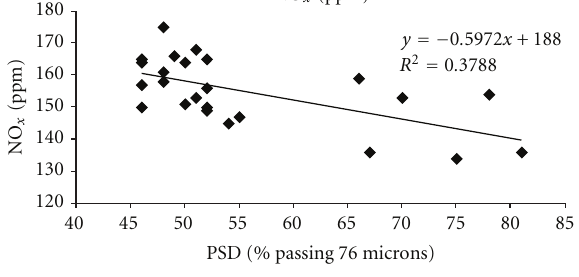
Figure 4: PSD versus NO x .